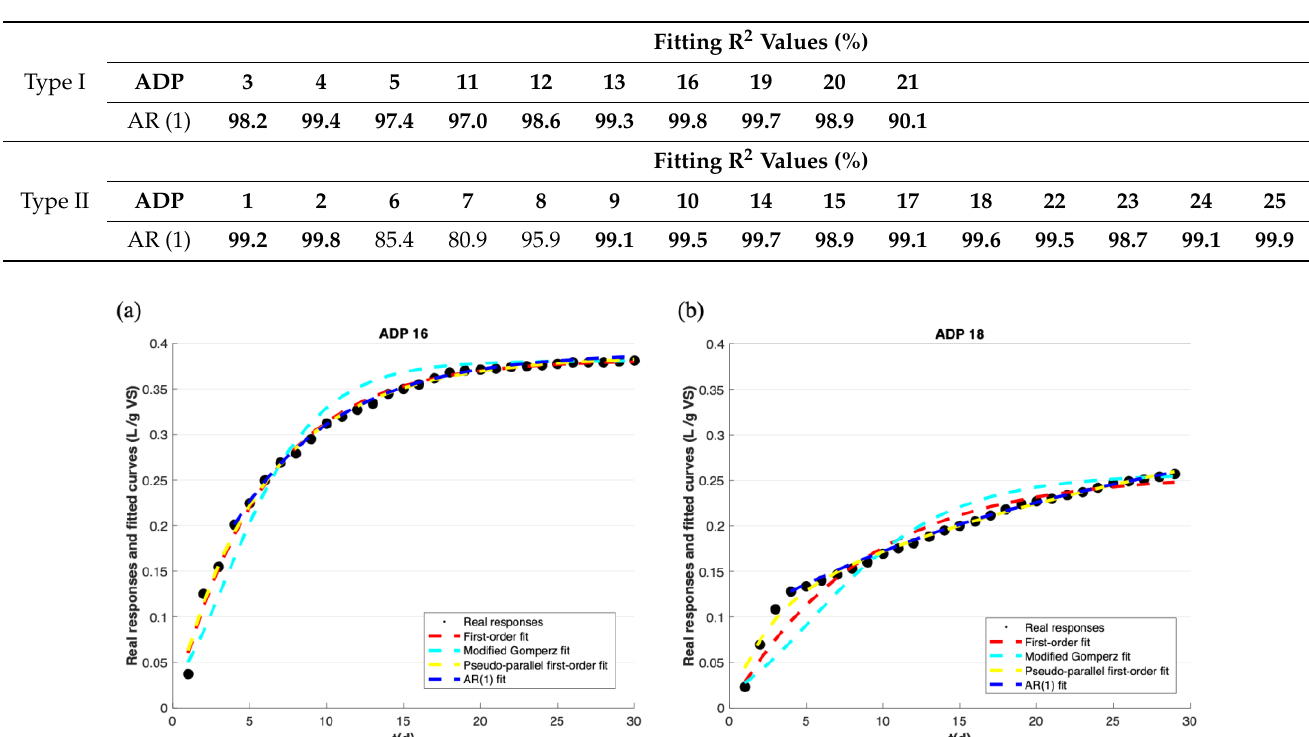
Figure 2. The fits of the three empirical models and the AR (1) model to the entire RBP test process for Type I ( a ) and Type II ( b ) data.